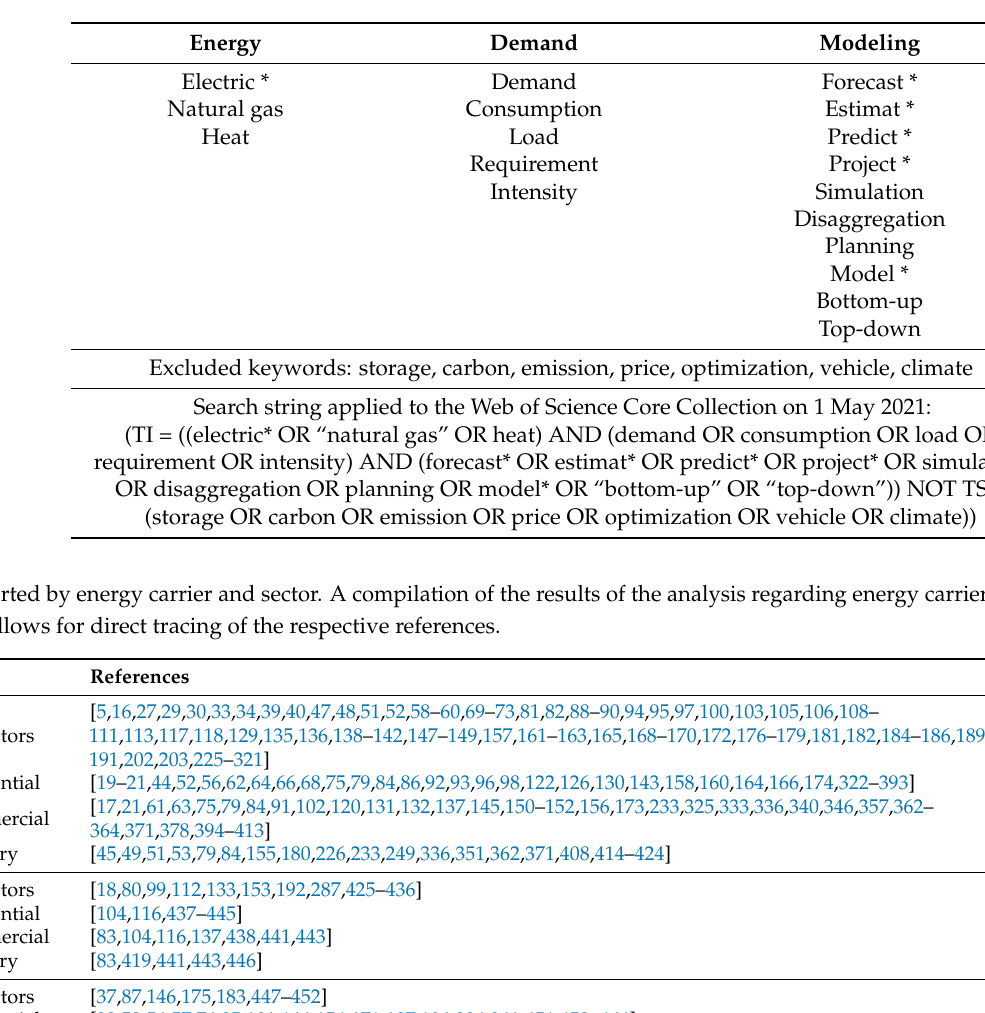
Table A2. Keyword compilation. The table contains the keywords used for the literature research arranged by thematic groups. Keywords in the bottom cell are explicitly excluded, which leads to a more precise search result. The * is a truncation operator to retrieve words with variant zero to many characters.